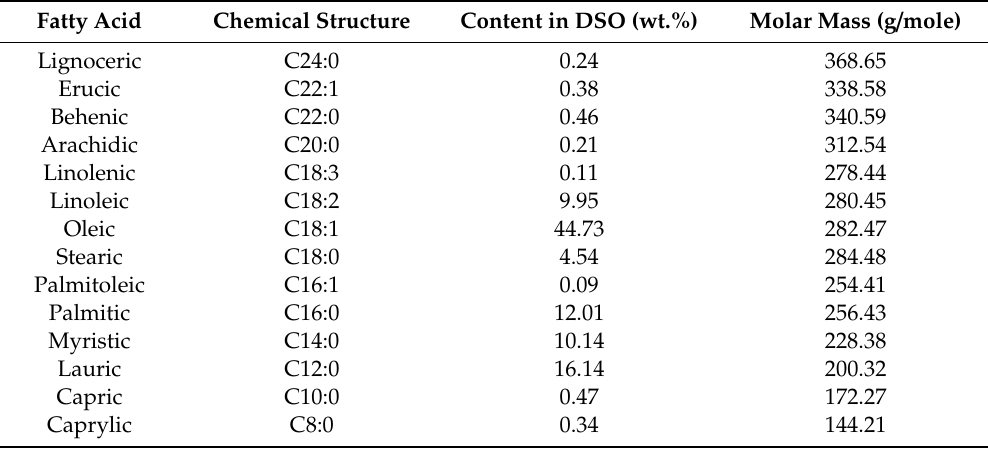
Table 1. Fatty acid profile of date-seed oil